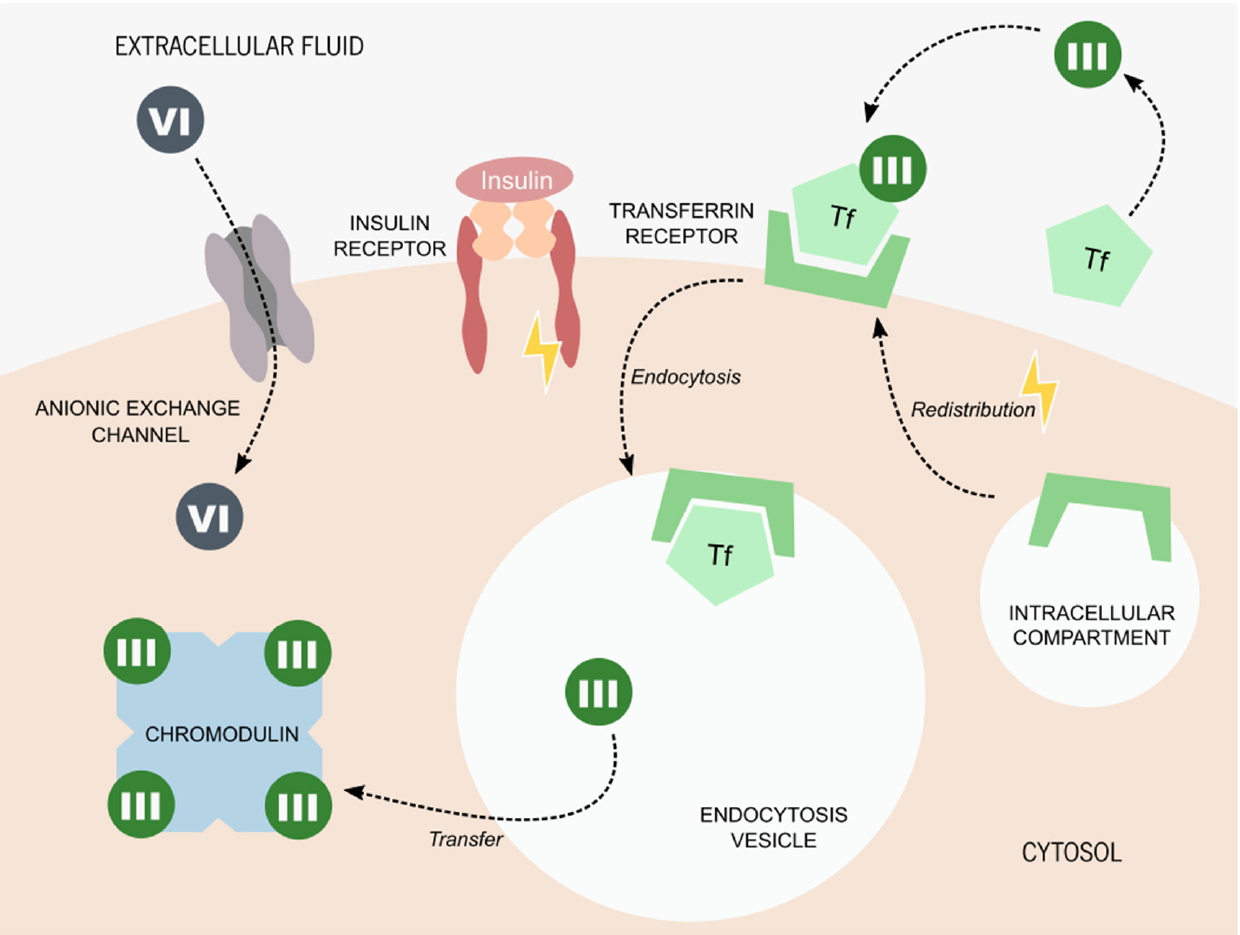
Figure 2. Proposed molecular mechanisms for chromium internalization. Chromium (VI) is usually found in the form of chromate oxyanion: [CrO4] 2 − , which is part of the chromate compounds. Its similar ionic structure to some essential anions allows chromium (VI) to enter living cells through its anionic exchange channels. The process of chromium (III) internalization is still a matter of debate. The most accepted hypothesis states that chromium (III) is captured by serum proteins, such as transferrin (Tf). The presence of insulin promotes the redistribution of the Tf receptor from intercellular compartments to the cytoplasmatic membrane. Tf bound to chromium (III) is captured by the Tf receptor and internalized by endocytosis. Once inside the cell, chromium (III) is transferred to chromodulin, an oligopeptide capable of binding to four equivalents of chromium ions. It is thought that chromodulin can enhance insulin effects on glucose and lipid metabolism.